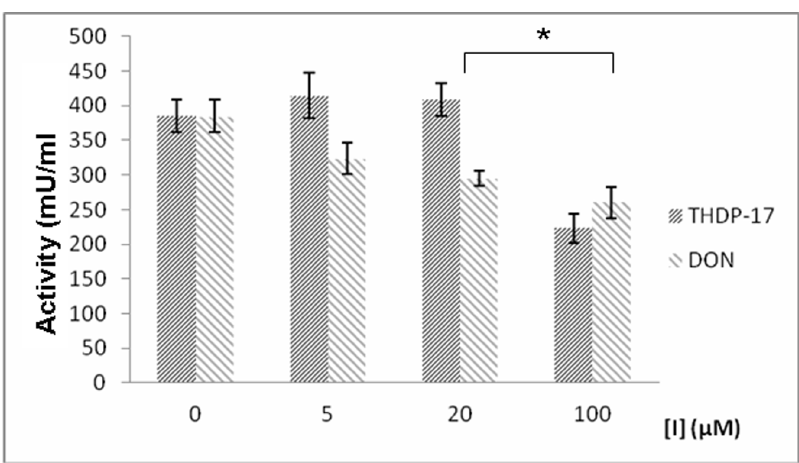
Figure 4. In vivo inhibitory effect on glutaminase activity at different concentrations of THDP17 and DON (6-Diazo-5-oxo-L- norleucine) was tested in Caco-2 cell cultures. PAG inhibition by THDP-17 in cell cultures is effective at concentration higher than 5 m M, showing an inhibition of 18 6 2.1% and 46 6 3.4% at 20 and 100 m M, respectively (* p , 0.05).